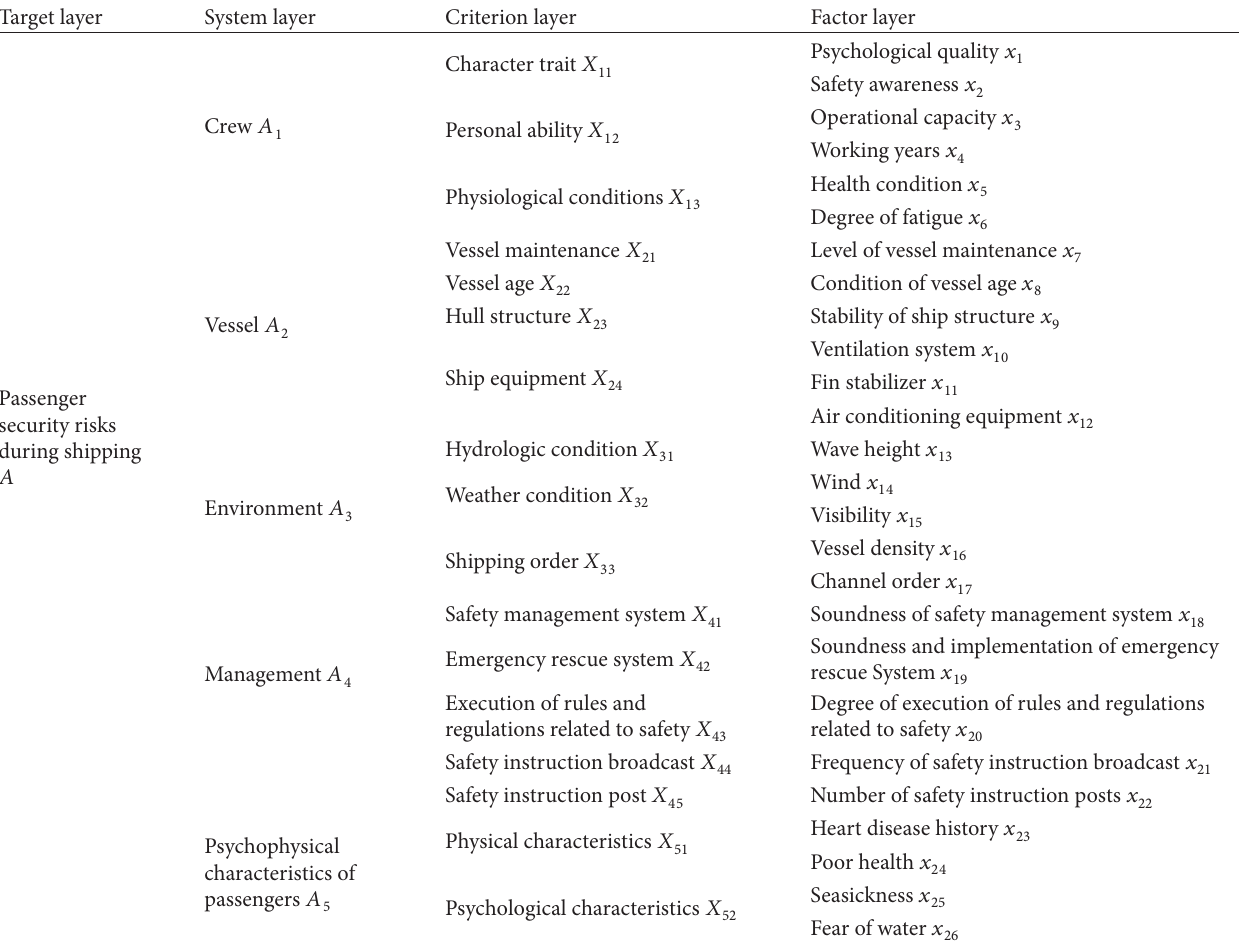
Table 2: Influencing index system of passenger security during